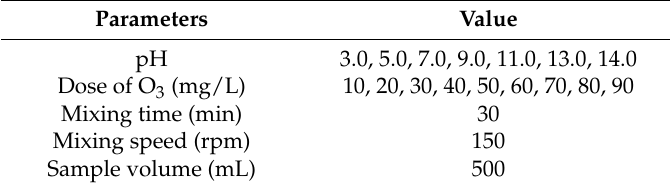
Table 2. The experimental conditions for O 3 -oxidation method.